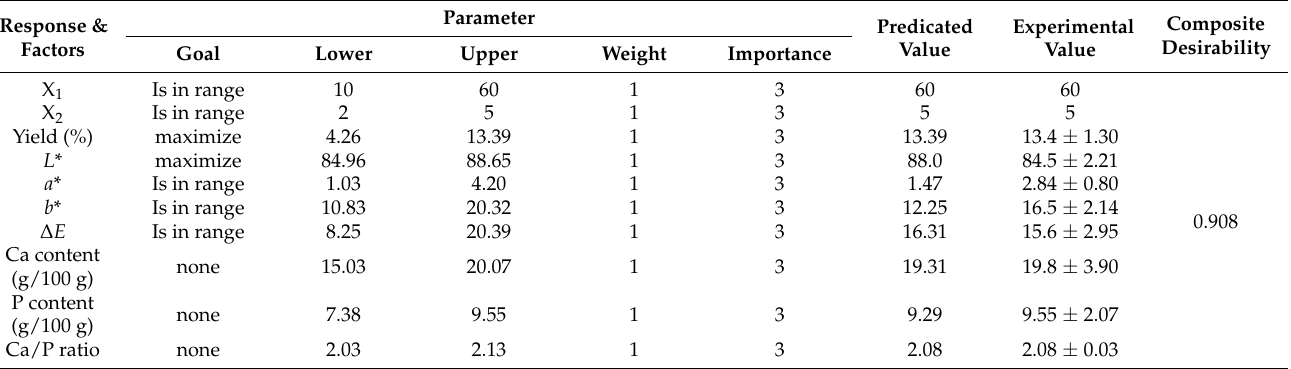
Table 3. Criteria of parameters for multi-response optimization, optimum condition, composite desirability, predicated value, and experimental value from the verification of optimum model for yield, L *, a *, b *, and ∆ E